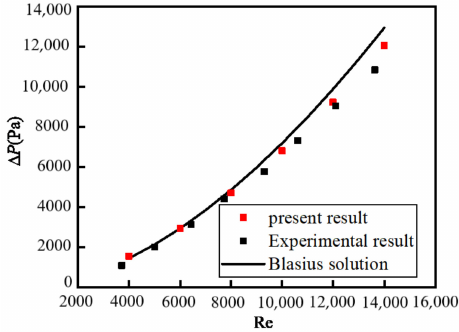
Figure 2. Relationship between ∆ P and Re.